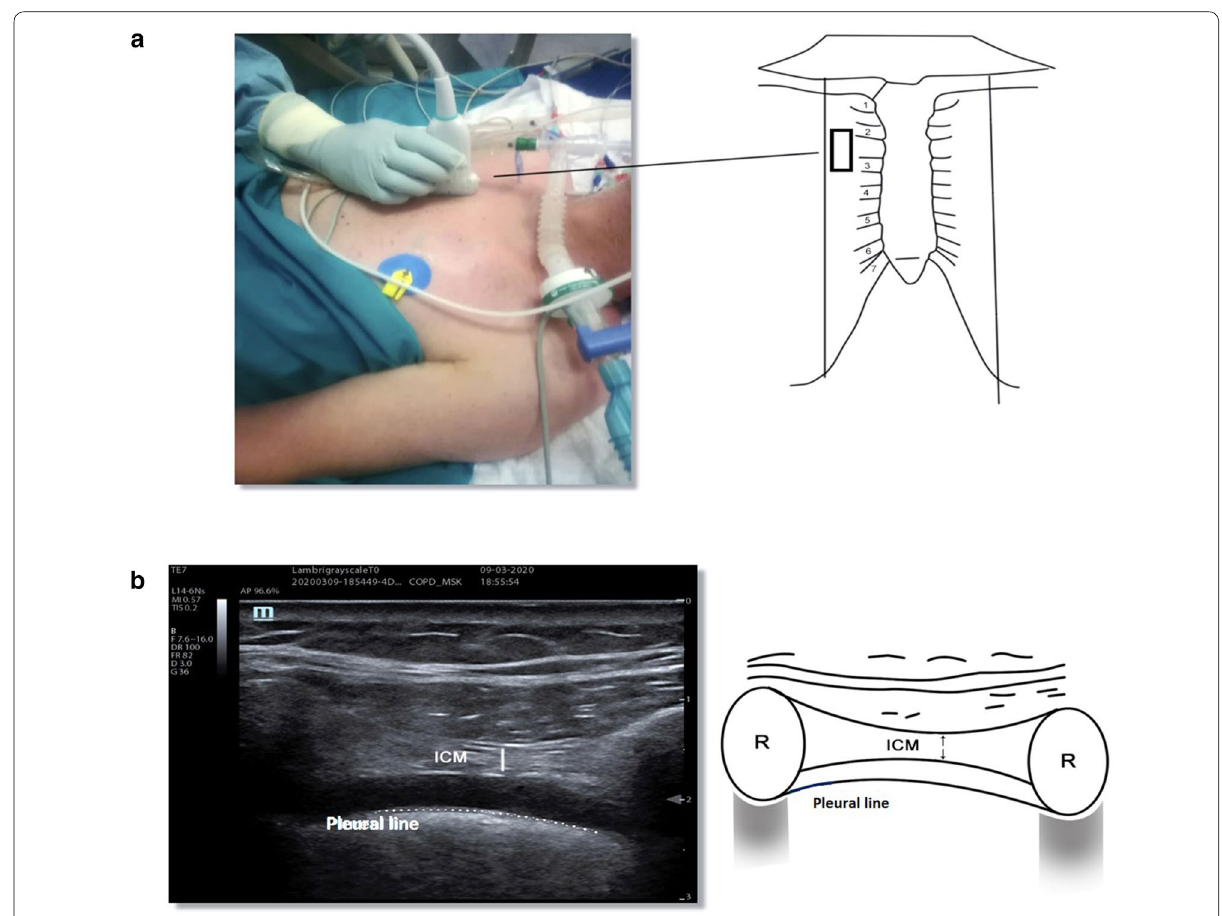
Fig. 2 Intercostal muscle ultrasound. The figure depicts an ultrasound image of parasternal intercostal muscle ultrasound. a The ultrasound probe position at the parasternal space. b The ultrasound image depicted by ultrasound using a B-mode setting in which the intercostal muscle lies between two ribs (R), cranial to the pleural line, behind the pectoral muscle. The left side is a schematic view of the ultrasound image. ICM intercostal